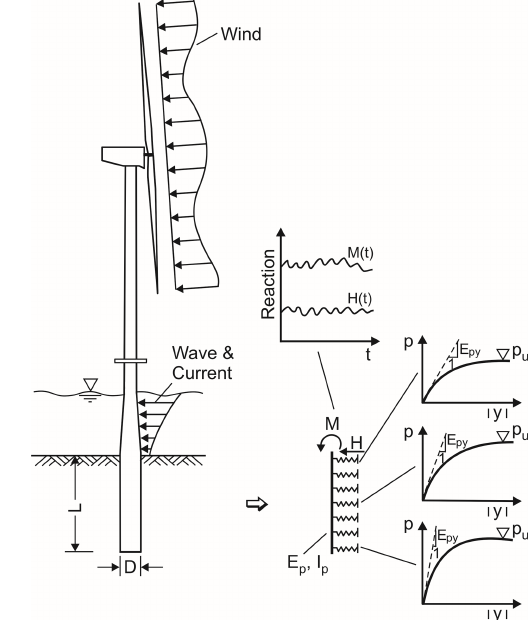
Figure 1. Monopile foundation of an offshore wind energy con- verter and p – y method used in design (schematic).